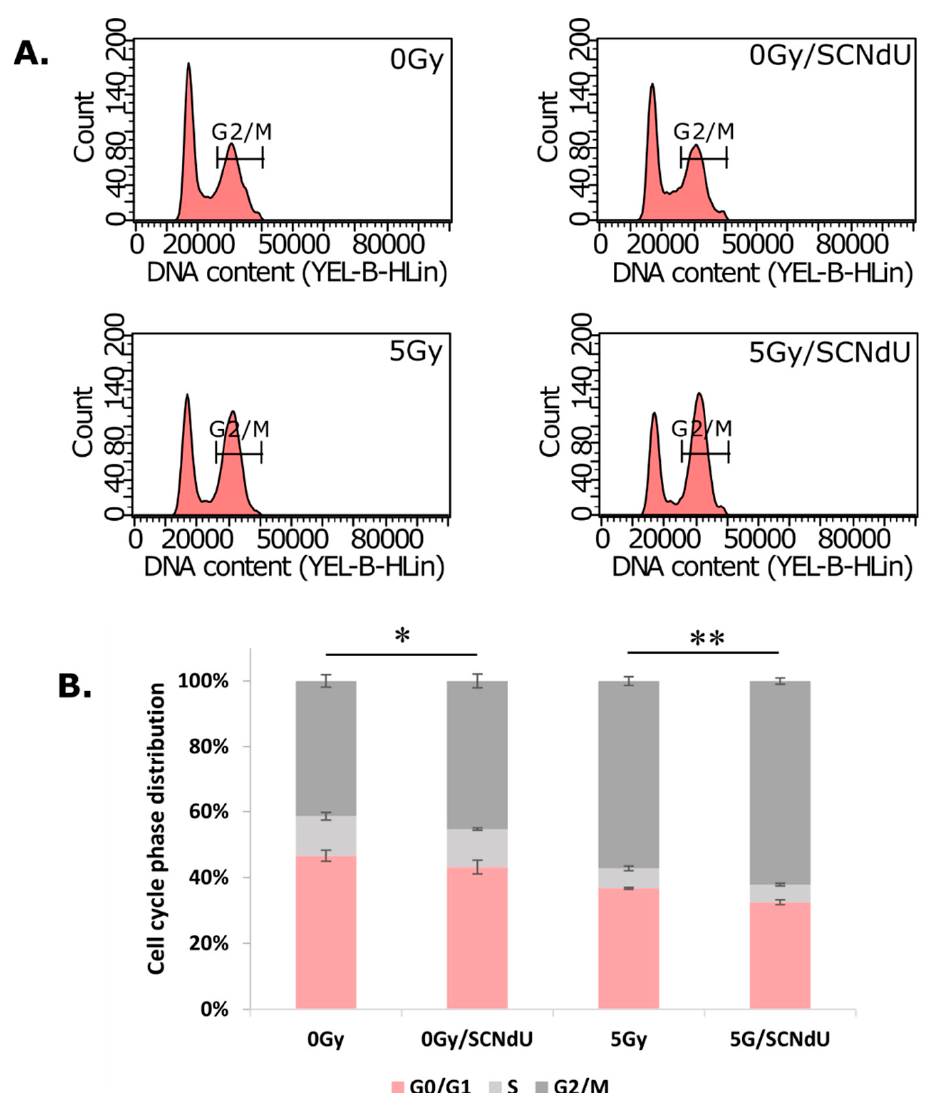
Figure 3. Effect of SCNdU on PC3 cell cycle distribution. ( A ) Cells were pretreated with SCNdU for 24 h before exposure to 0 Gy or 5 Gy radiation, and the fraction of cells in each phase of the cell cycle was analyzed by flow cytometry. ( B ) Quantitative analysis of cell cycle distribution. The results are expressed as mean ± SD. Statistical notations for differences in cell populations in G2/M between indicated groups * p < 0.05, ** p < 0.01.